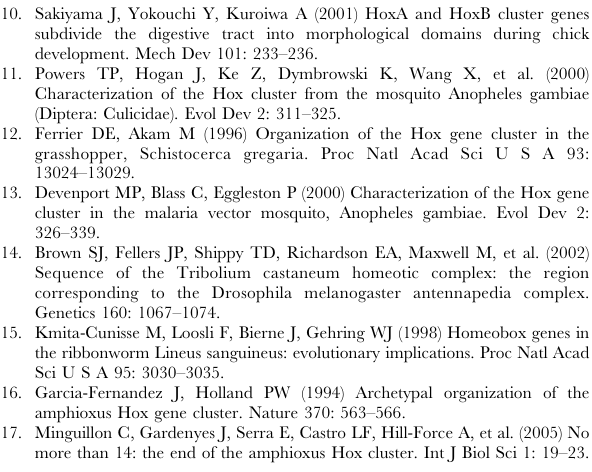
Figure S9 Annotated Gbx cluster of Nematostella . Gbx was localized to a single 117,312 nucleotide genomic scaffold (c402901116.Contig1) from the Phusion assembly of the Nematos- tella genome. The sequence of Gbx was determined by conceptually splicing overlapping 5 9 and 3 9 RACE products. A (scaffold-58) [55]. A TBLASTN analysis of the scaffold against HLXc located approximately 601,580 nucleotides upstream of Gbx. The figure is labeled as Figure S3. Figure S10 Annotated Dlx-NVHD021 cluster of Nematostella . Dlx and NVHD021 are located 6988 nucleotides apart on a single genomic scaffold (c413501012.Contig1) from the Phusion assem- bly of the Nematostella genome. The sequence of Dlx was was determined by conceptually splicing overlapping 5 9 and 3 9 RACE products, while the longest open reading frame downstream of NVHD021 homeodomain was inferred using MacVector 7.2.3